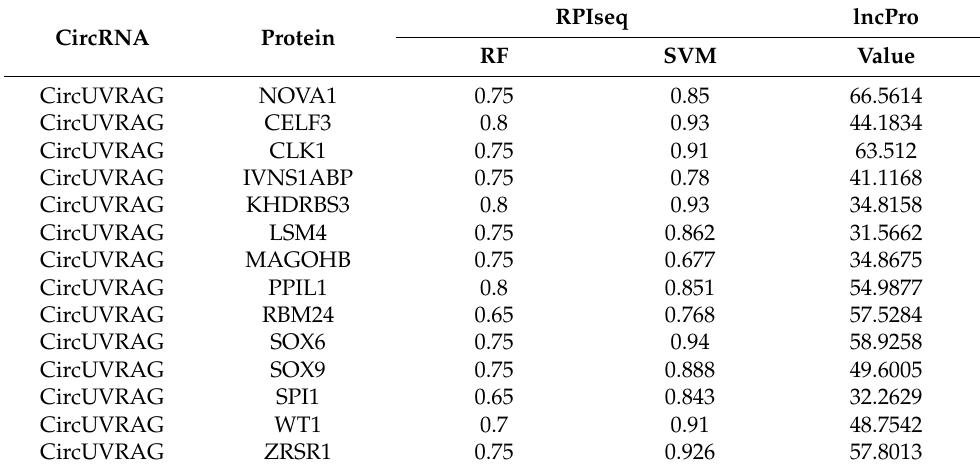
Figure 4. The splicing factor NOVA1 co-localizes with UVRAG pre-mRNA in the nucleus. ( A ). Intersecting the 3044 differentially expressed (DE) genes obtained by whole-transcriptome sequencing with the 333 genes related to alternative splicing annotated by the Ingenuity Pathway Analysis (IPA) database, we identified 14 DE alternative splicing factors. ( B ). The heat map shows that NOVA1 is decreased in the graft vein. ( C ). Immunofluorescence and fluorescence in situ hybridization assays indicate that NOVA1 protein and UVRAG pre-mRNA co-localize in the nucleus. NOVA1 protein is green and UVRAG pre-mRNA is red. The two types of fluorescence at the position indicates by the white arrows are superimposed in yellow (Bar = 25 µ m, and 7.5 µ m). ( D ). NOVA1 might be involved in the formation of circUVRAG in VSMCs. Table 1. The NOVA1 protein may bind to the circUVRAG.